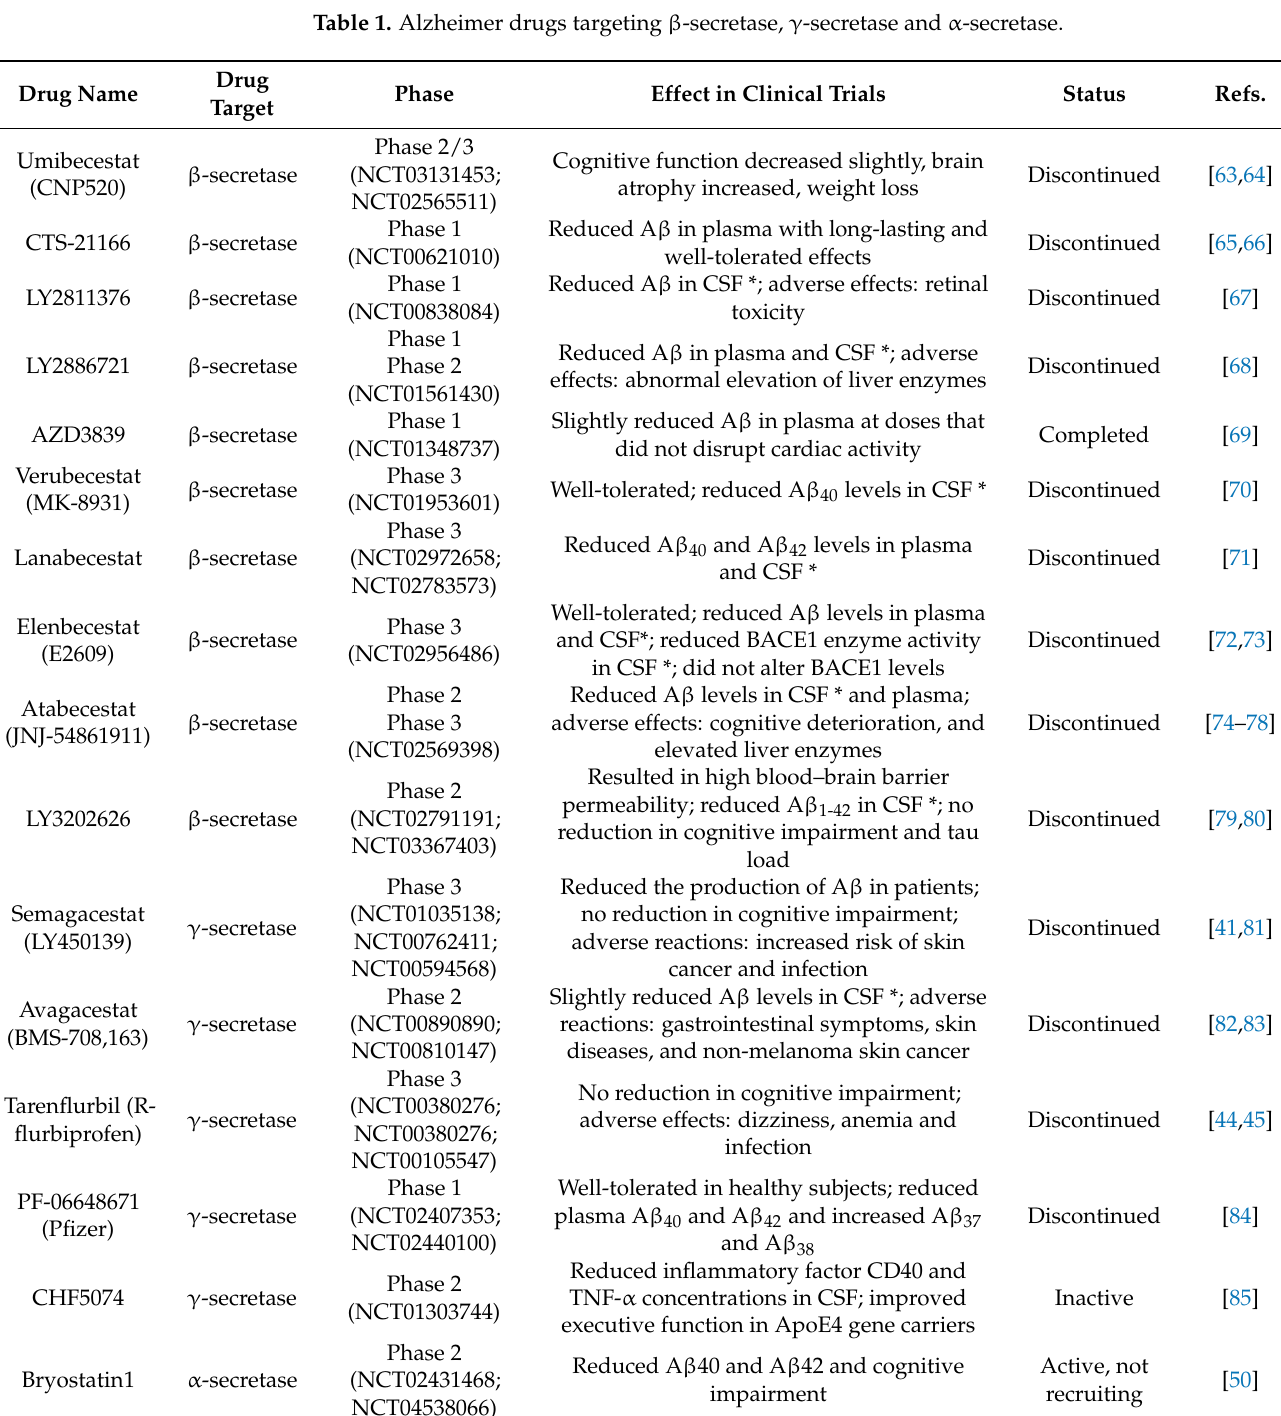
Table 1. Alzheimer drugs targeting β -secretase, γ -secretase and α